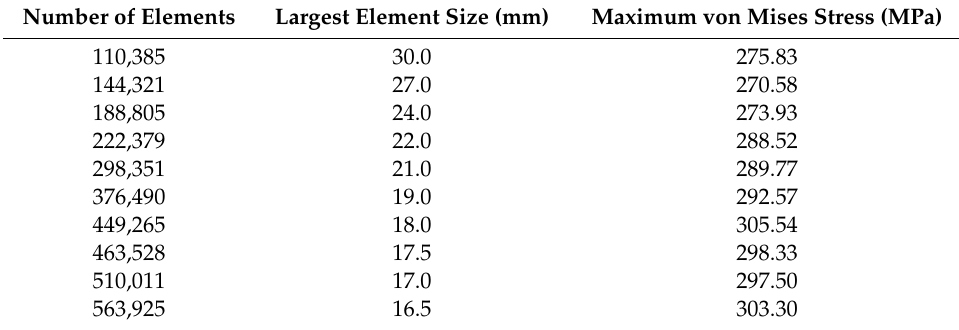
Table 2. Grid independence study for the inferior triangular bracket subjected to the ALS condition of